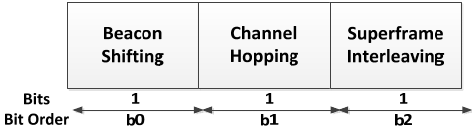
Figure 15. Coexistence Format of IEEE 802.15.6